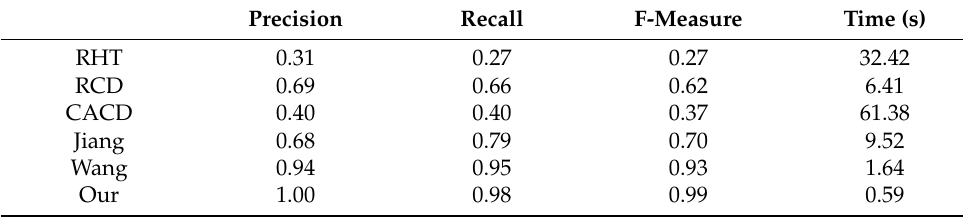
Table 6. Result of RHT, RCD, CACD, Jiang, Wang and our method in the dataset Geometry. Precision